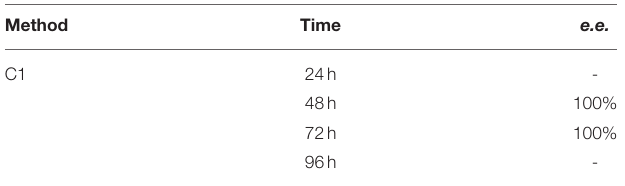
TABLE 2 | Results of biotransformation of the racemic mixture of 1-amino-1(2-thienyl)methylphosphonic acid (substrate 1 ) using an immobilized biocatalyst.